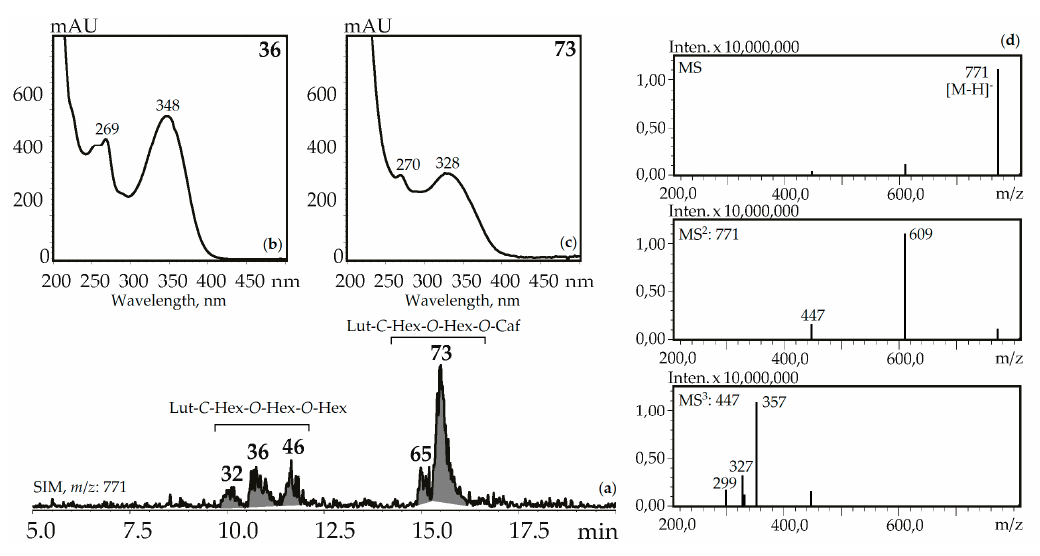
Figure 6. ( a ) HPLC-ESI-MS chromatogram of G. gelida herb extract in SIM-mode ( m / z 771). ( b , c ) UV spectra of compounds 36 and 73 . ( d ) MS n spectra (negative ionization) of compound 36 . Lut- C -Hex- O -Hex- O -Hex—zone of isomeric luteolin- C -hexoside- O -hexoside- O -hexosides, Lut- C -Hex- O -Hex- O -Caf—zone of isomeric luteolin- C -hexoside- O -hexoside- O -caffeates. Three luteolin- C -hexoside- O -di-hexosides ( 32 , 36 and 46) with the same UV pattern gave MS n